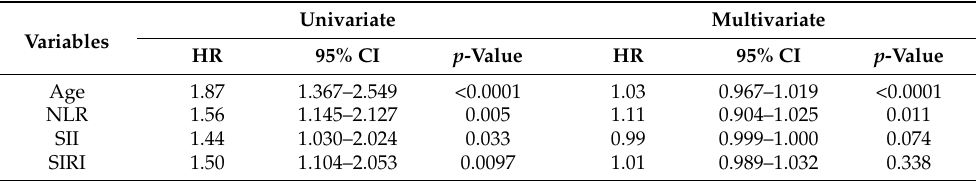
Table 5. Univariate and multivariate Cox model analysis for Grade 4 tumour patients ( n = 178). Univariate Multivariate Variables HR 95% CI p -Value HR 95% CI p -Value Age